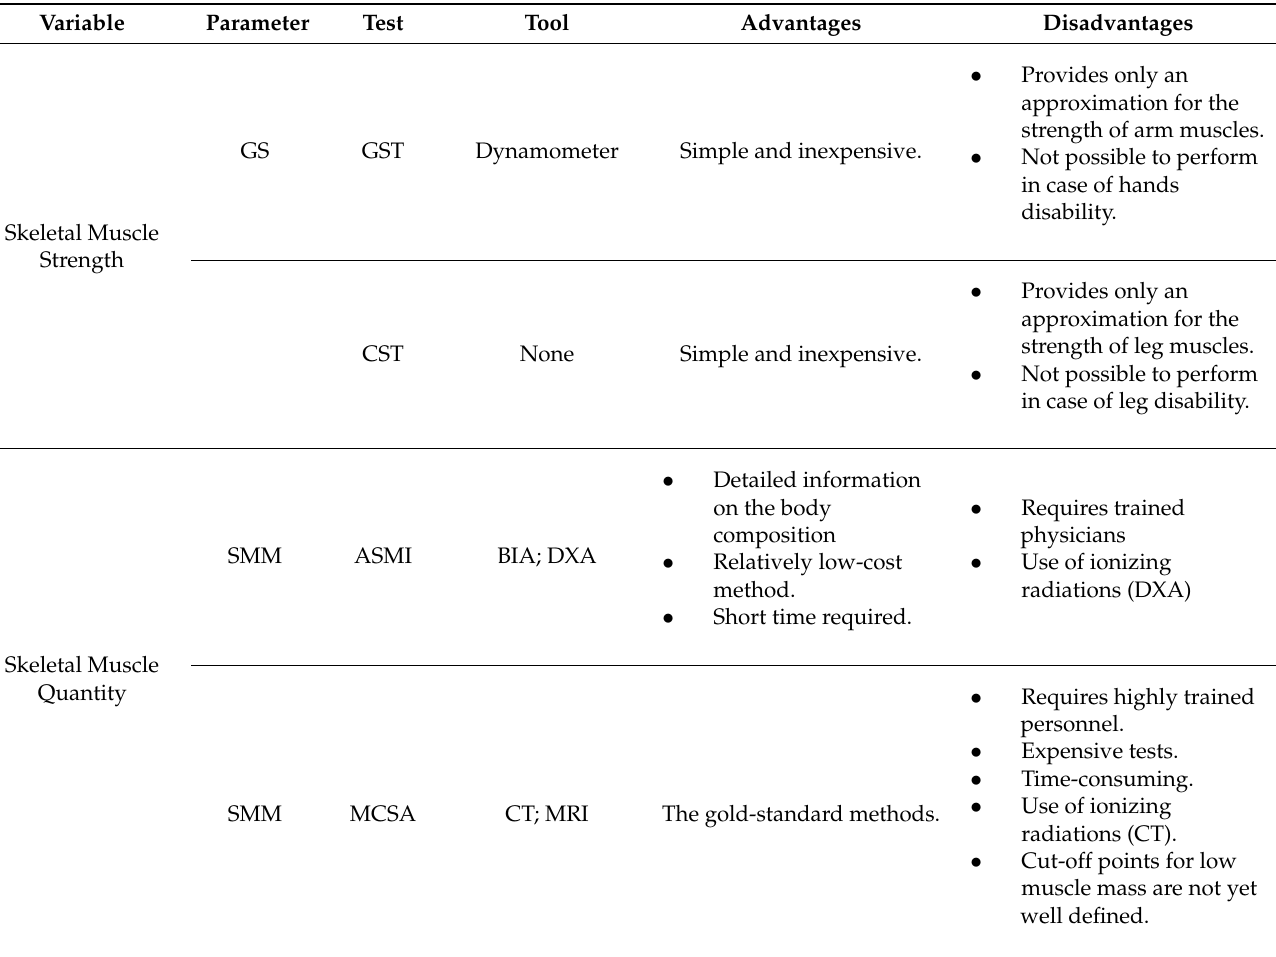
Table 1. Validated tests for the assessment of muscle strength and muscle